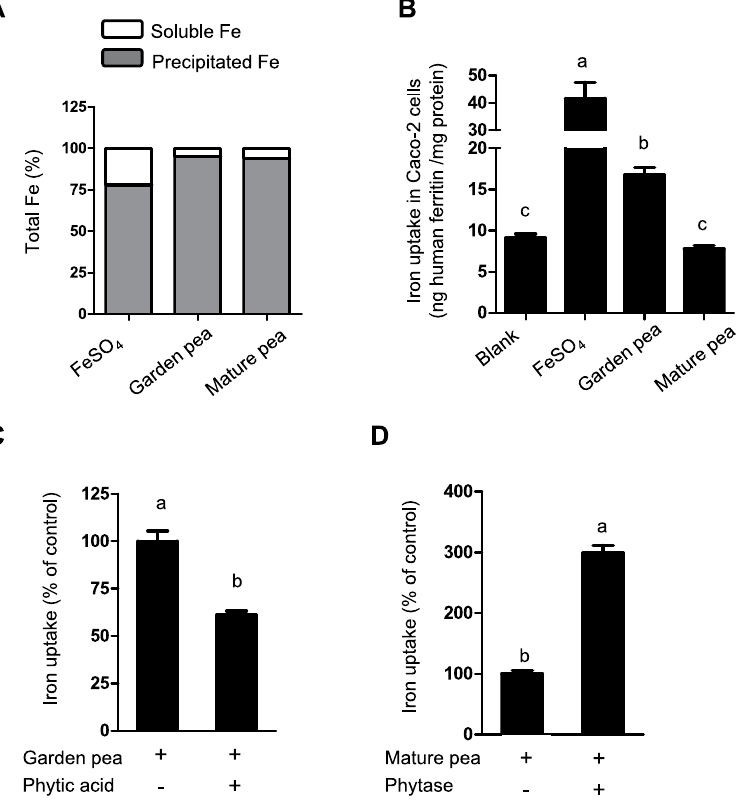
Figure 7. Iron in cooked immature garden peas is more bioavailable than in mature peas. ( A ) Percentage of soluble and precipitated iron in the final step of the simulated gastrointestinal digestion. ( B ) Iron uptake in Caco-2 cells exposed to the digestates of microwaved (immature) garden peas and boiled mature peas. ( C ) Percentage of change in iron uptake into Caco-2 cells after adding phytic acid to the simulated digestion of garden peas, and ( D ) after adding phytase enzyme to the simulated digestion of mature peas. Data represent means ± SEM from 3–4 different simulated digestions which were each applied in triplicate to Caco-2 cells. Means without a common letter differ ( p < 0.05, using one-way ANOVA for (B) and Student t -test in ( C and D ).